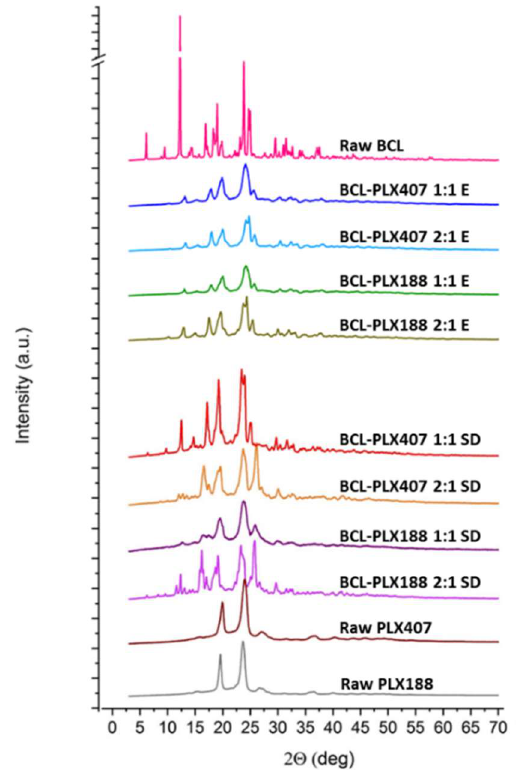
Figure 4. X-ray diffraction patterns of binary systems containing bicalutamide and either PLX 188 or PLX 407 (1:1 and 2:1 wt. ratio) obtained using evaporation technique (E) and spray drying (SD).